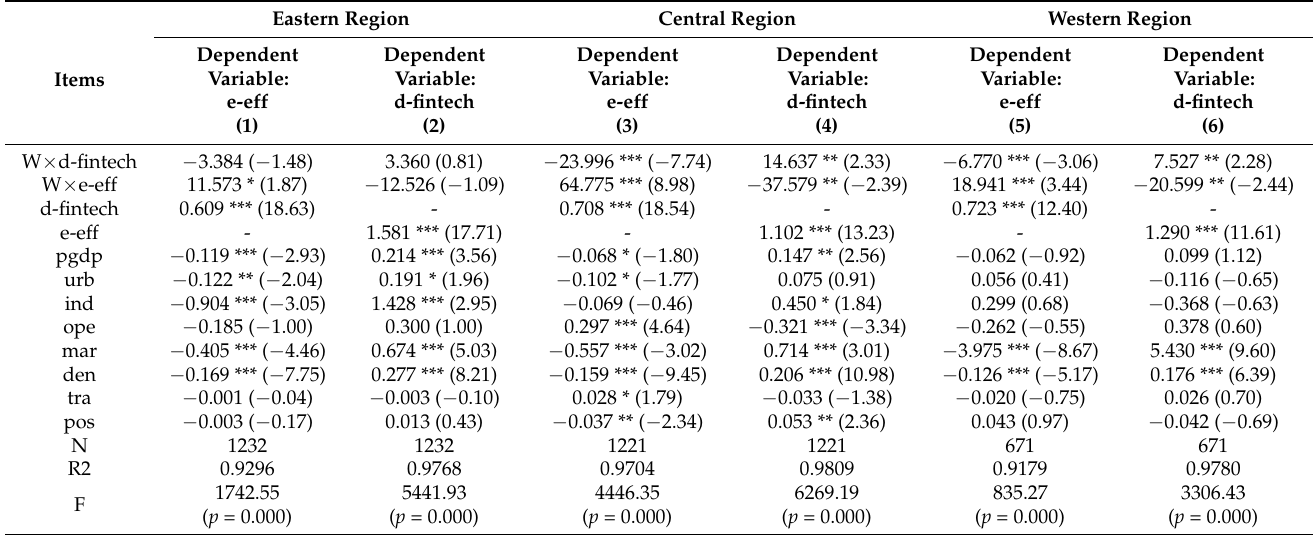
Table 10. Regional estimation results of GS3SLS (spatial weight of economic–geographical